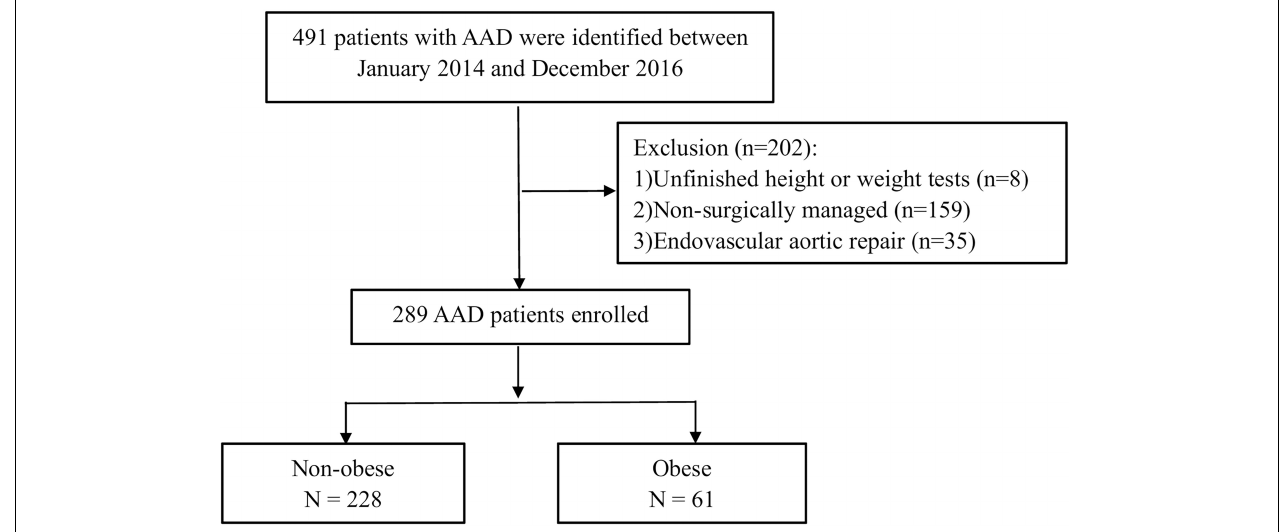
FIGURE 1 | A flowchart of patient